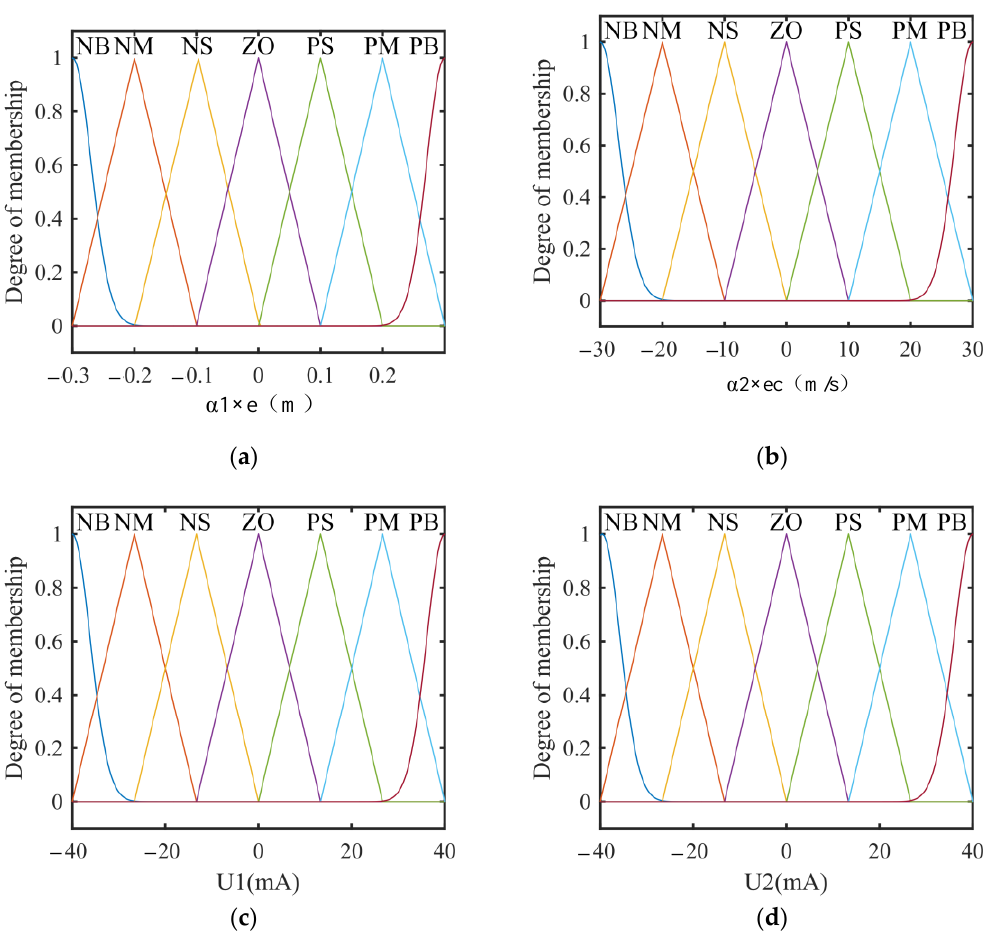
Figure 9. Membership function of the input and output variables of the fuzzy controller I. ( a ) Mem- bership function of α 1 × E . ( b ) Membership function of α 2 × EC . ( c ) Membership function of U1 . ( d ) Membership function of U2 .